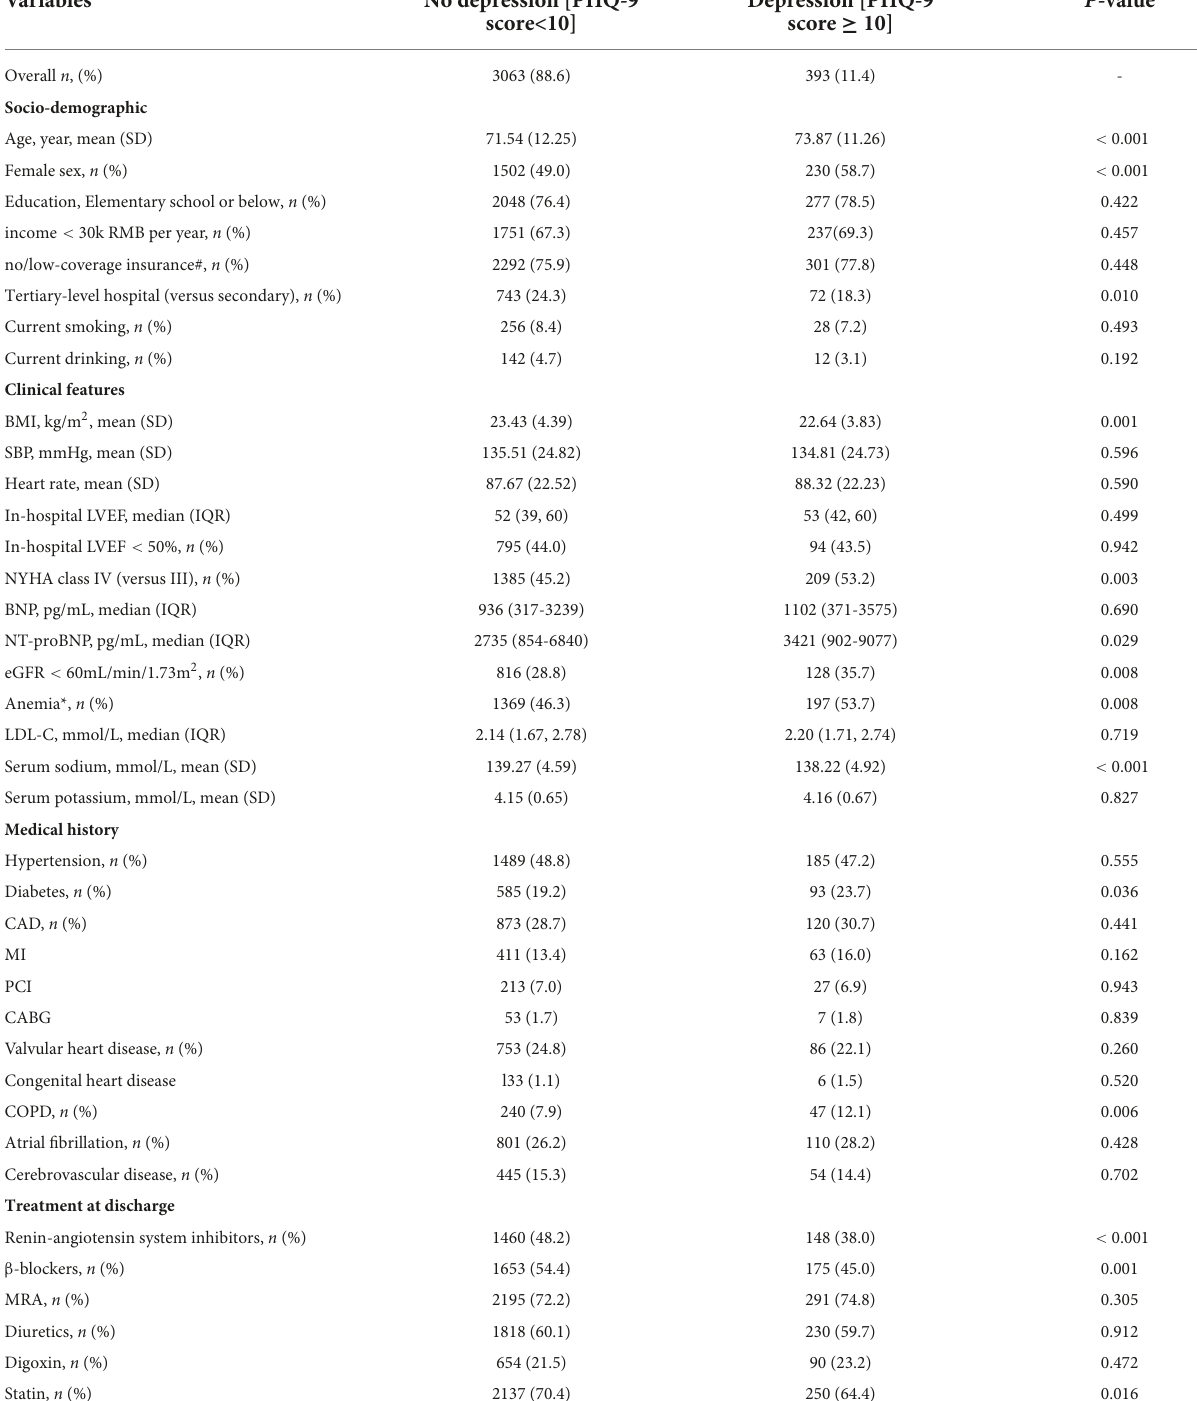
TABLE 1 Baseline